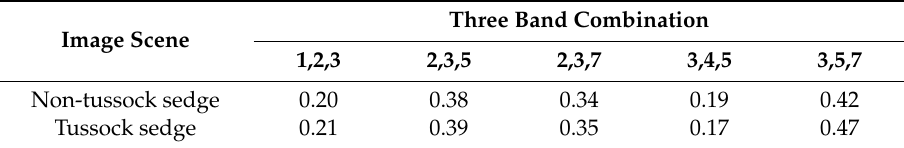
Table 2. Summary statistics of Root Mean Square Error (RMSE) for candidate scenes.